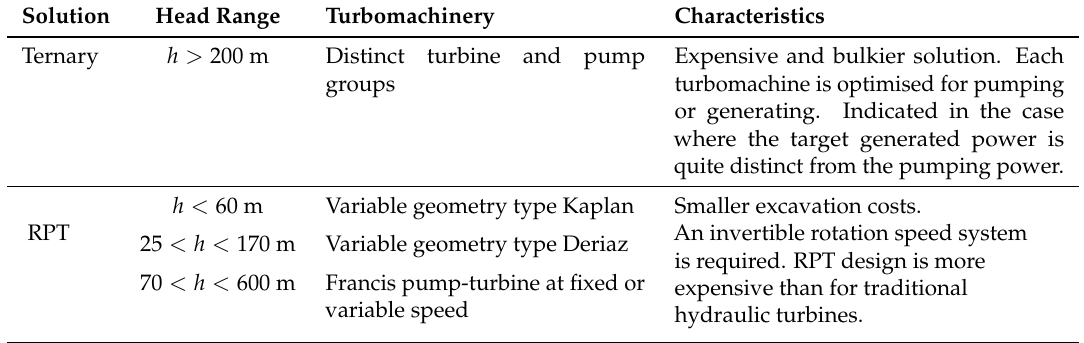
Table 2. Available turbomachinery solutions for Underground Pumped Storage Hydroelectricity